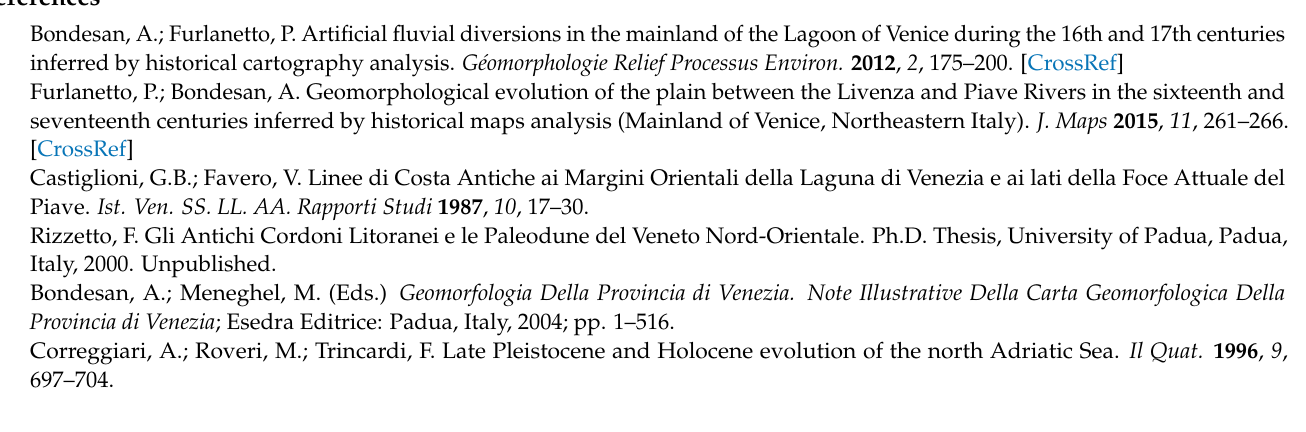
Table S9: samples collected from the sandy ridges of the fourth progradation phase (Ph4). The grain- size parameters (i.e., mean (MZ, Ø units), sorting, skewness, and kurtosis) and their classification are also indicated. Sorting ( σ 1): VWS = very well sorted, WS = well-sorted, MWS = moderately well sorted. Skewness (Sk1): VPS = very positive skewed, PS = positive skewed, nS = near-symmetrical, NS = negative skewed. Kurtosis (Kg): EL = extremely leptokurtic, VL = very leptokurtic, L = lep- tokurtic. Table S10: samples collected from the sandy ridges of the fifth progradation phase (Ph5). The grain-size parameters (i.e., mean (M Z , Ø units), sorting, skewness, and kurtosis) and their classi- fication are also indicated. Sorting ( σ 1 ): WS = well-sorted, MWS = moderately well sorted.